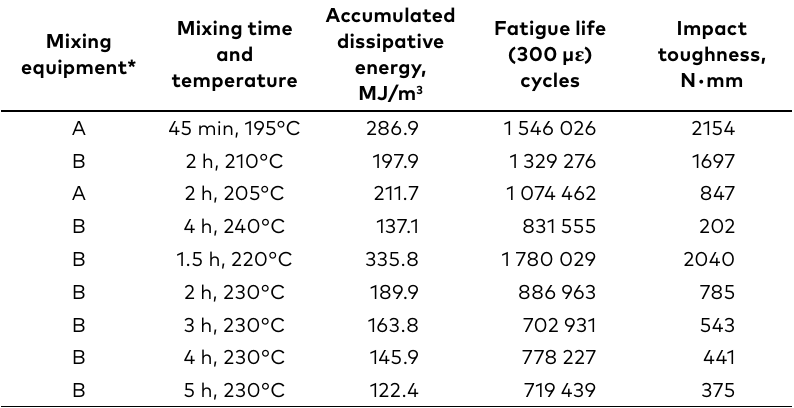
Table 4. Results of four-point bending beam fatigue and impact-loading tests